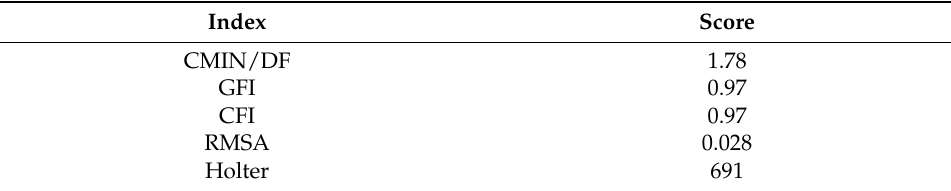
Table 5. The goodness of fit indexes.